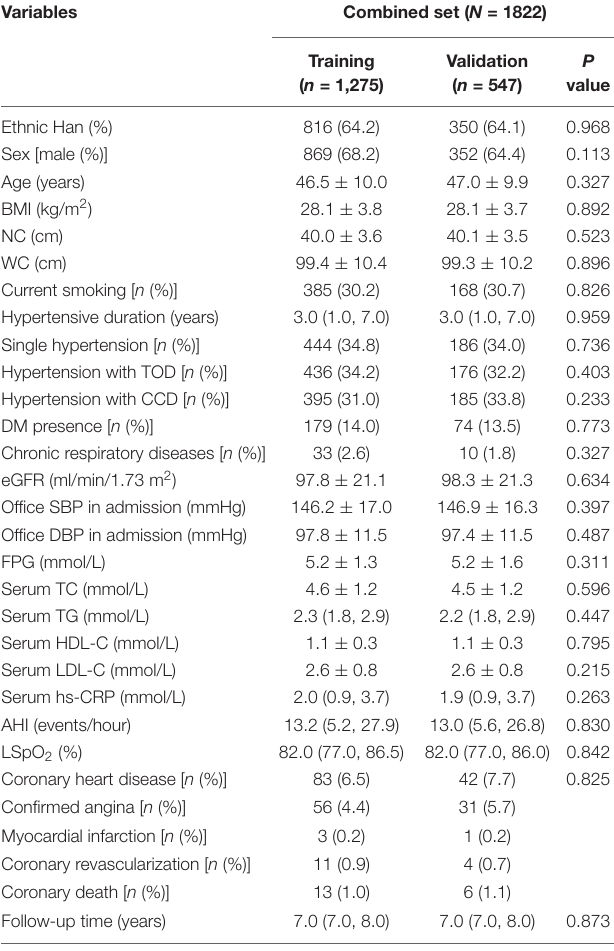
TABLE 1 | Comparison of characteristics between training and validation sets. Variables